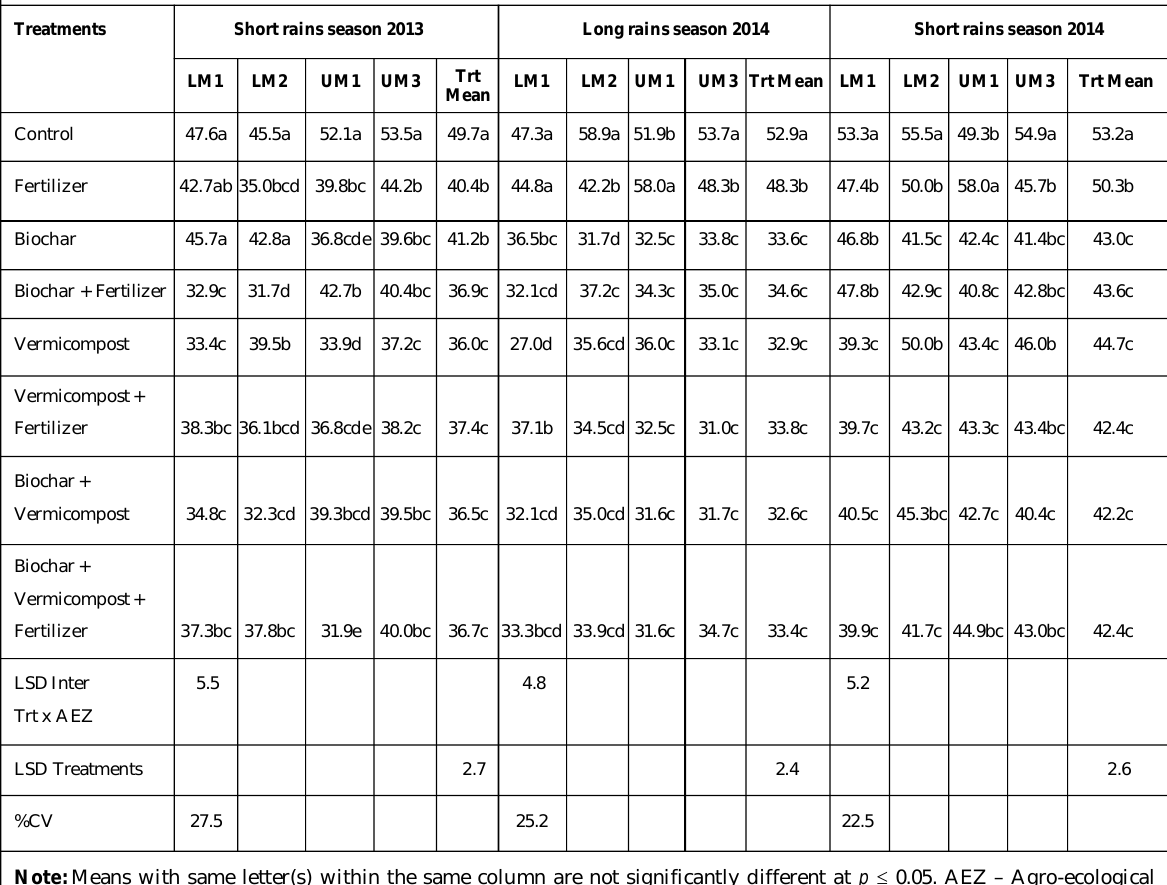
Table 6: Effect of different treatment on bean root rot severity (%) two weeks after planting in the long and short rains seasons of 2013 and 2014 in the four AEZs Treatments